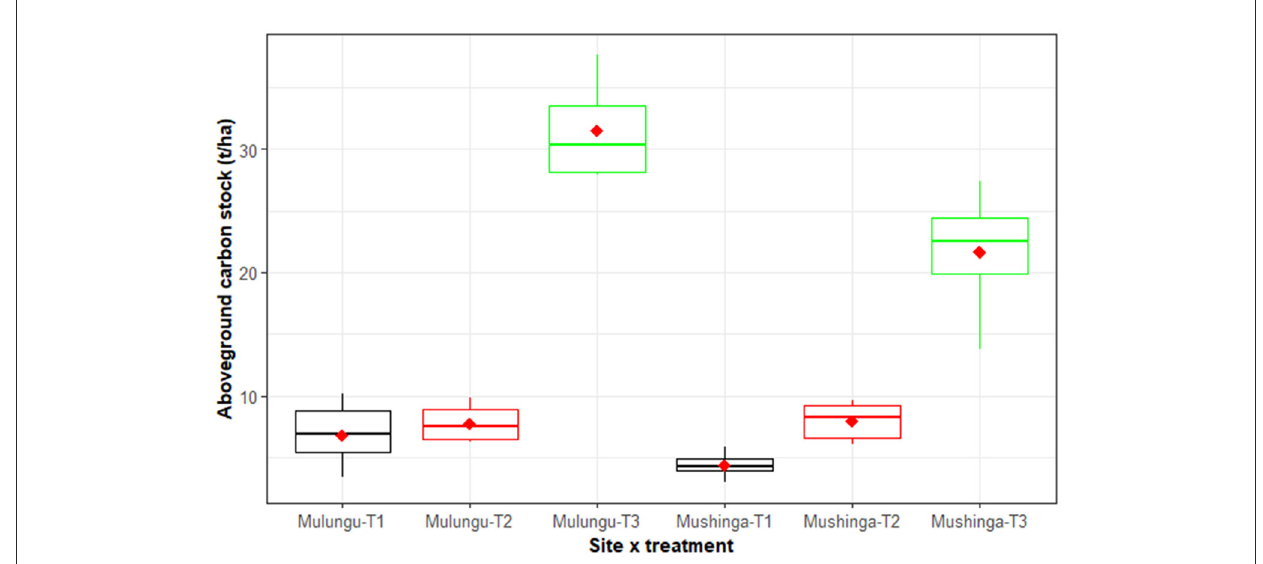
FIGURE6 Mean organic carbon stocked in aboveground biomass for three management practices across two sites (Mushinga and Mulungu), assessed after 4 years of experimentation. The management practices included T3: an agroecological package integrating grasses, shrubs and mucuna cover crop, T2: burning of crop residues and weeds with NPK and manure application, and T1: burning of crop residues and weeds without NPK and manure application. The horizontal line within each box is the median, while the diamond shaped symbol within the box is the mean. The lower and upper boundaries of the boxes are, respectively, the 25th and 75th percentile; the bars/whiskers below and above the box are the 10th and 90th percentile and points beyond 10th and 90th percentiles are